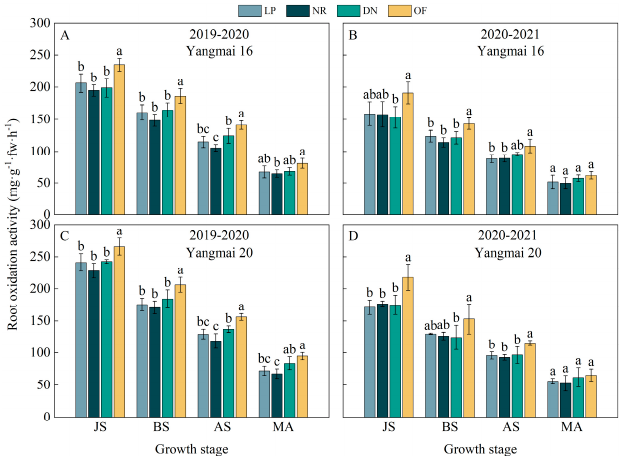
Figure 2. Effect of integrated cultivation practices on root oxidation activity of two wheat cultivars Yangmai 16 ( A , B ) and Yangmai 20 ( C , D ). LP, NR, DN, and OF indicate local practices, nitrogen reduction, planting density reduction and nitrogen reduction, and organic fertilizer, respectively. JS, BS, AS, and MA indicate the jointing stage, booting stage, anthesis stage, and maturity, respectively. Vertical bar represents the ± standard error of the mean. Different lowercase letters indicate the same period; the difference between different treatments was significant at the 0.05 level.